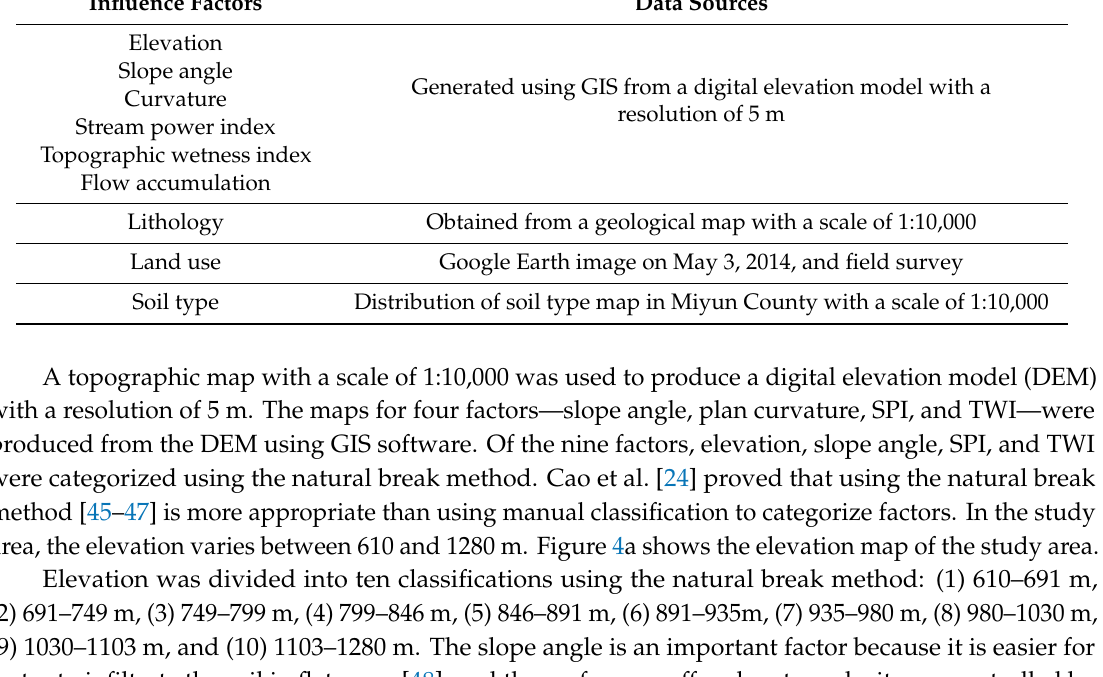
Table 1. A list of data sources of each influencing